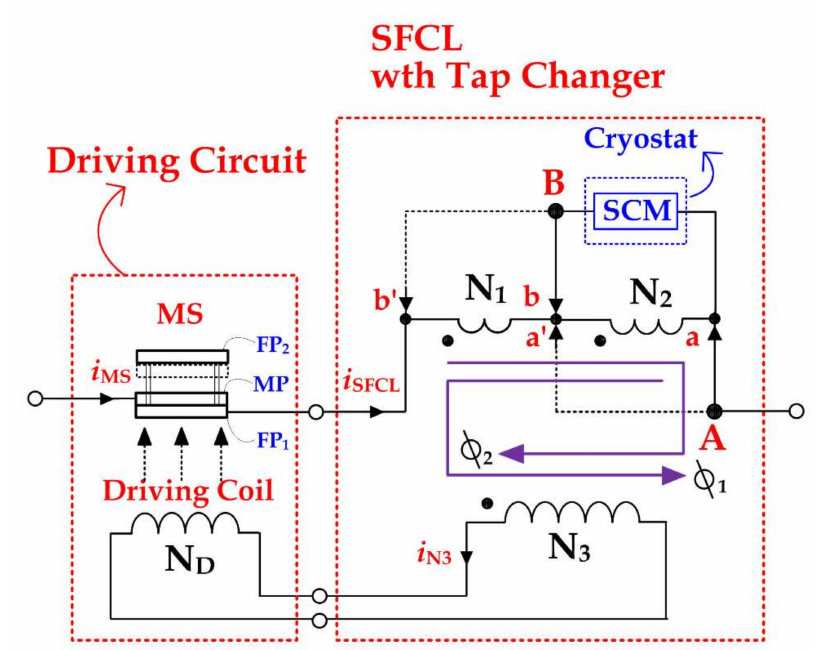
Figure 1. Schematic configuration of proposed superconducting fault current limiting breaker (SFCLB) using flux coupling with a tap